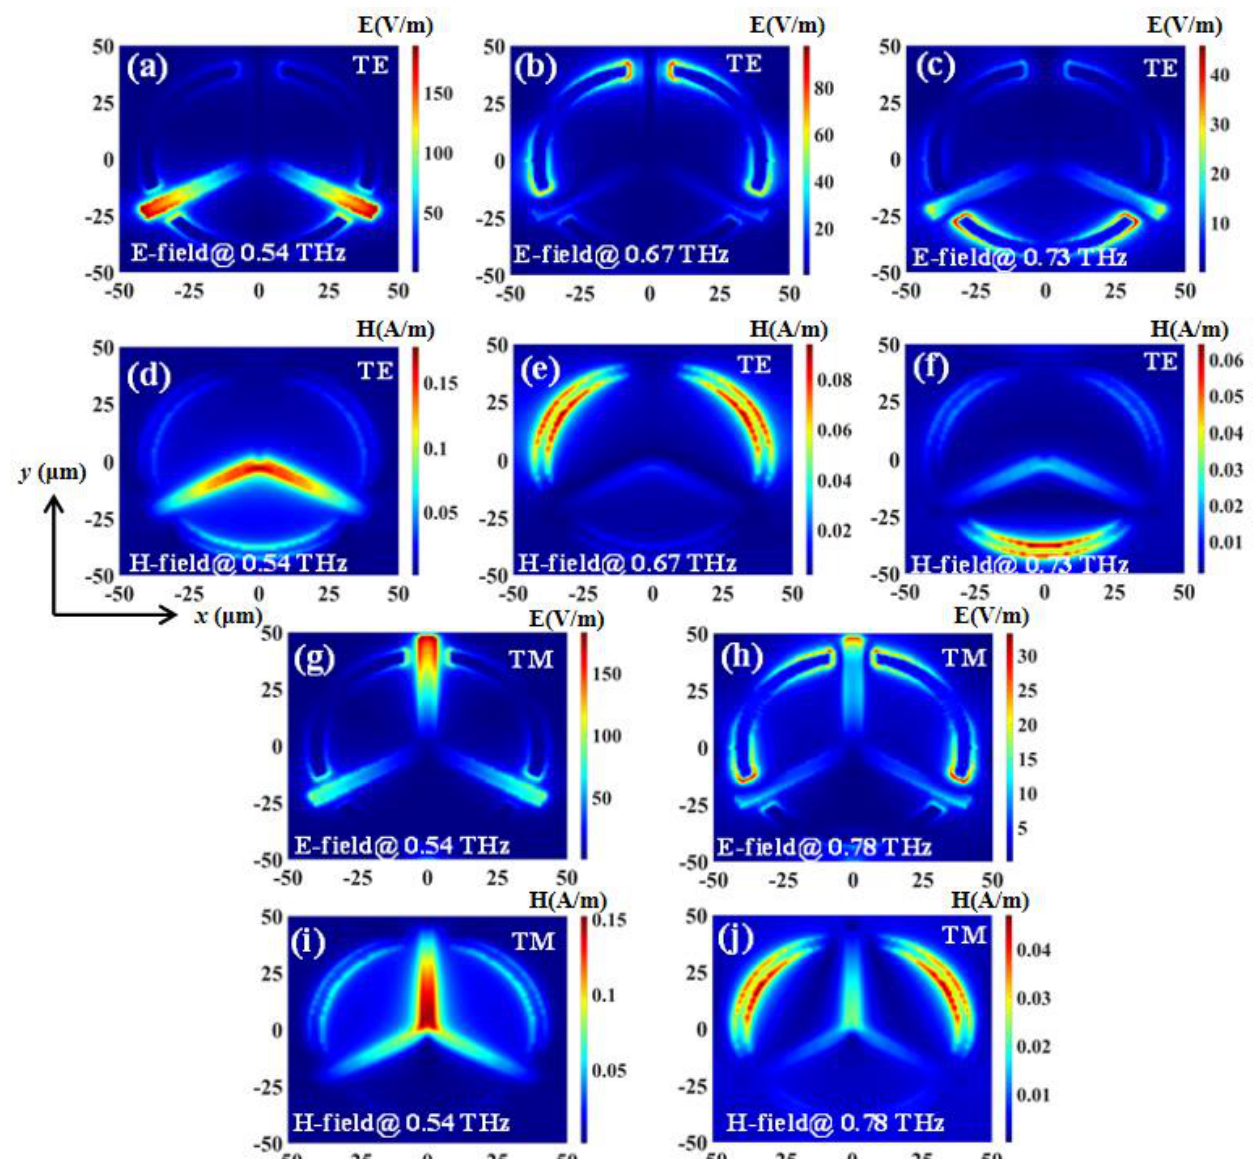
Figure 9. Field distributions of TTM with h = 1 μm in TE and TM modes. ( a – c , g , h ) are E-field distributions. ( d – f , I , j ) are H-field distributions.